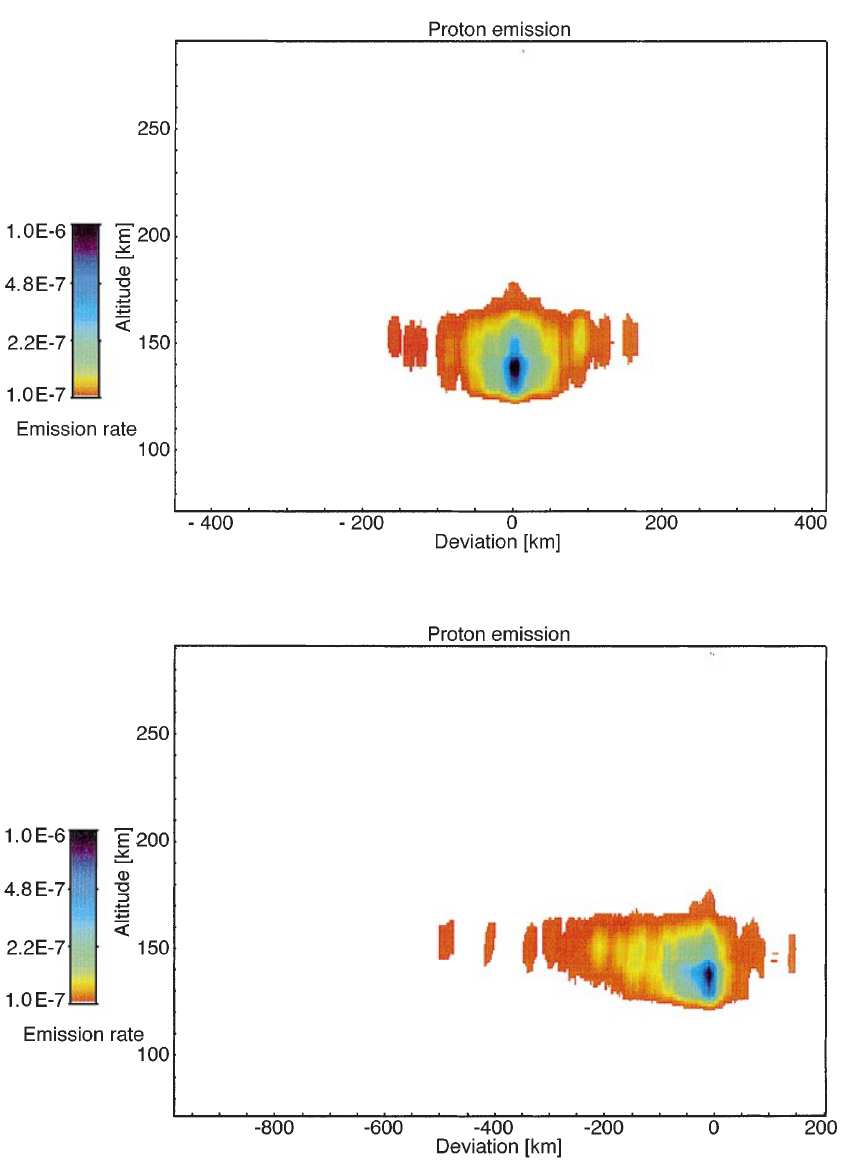
Fig. 6. Modeled auroral hydrogen arc in the north-south geomagnetic direction, for particles with injection energies of 5 keV and isotropic pitch angle